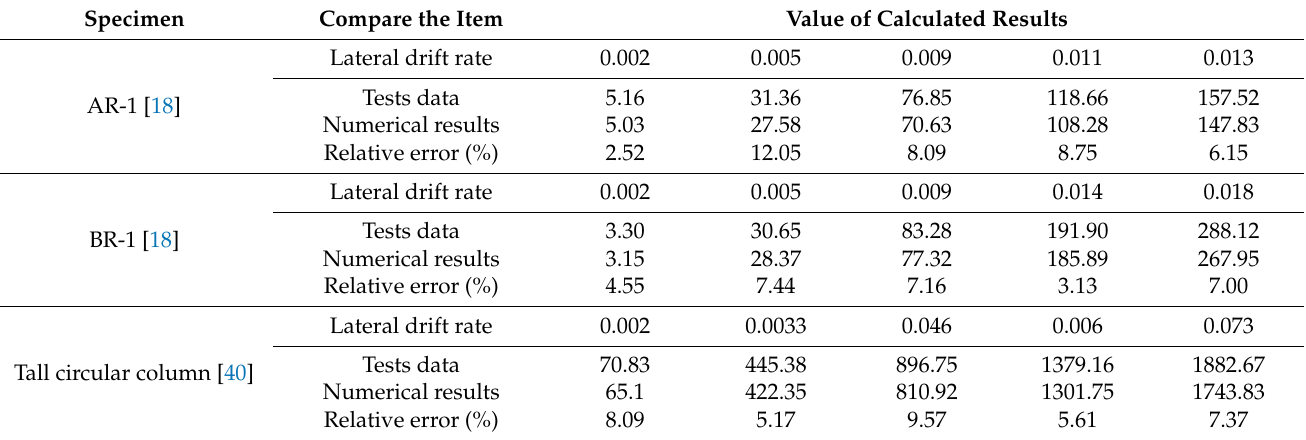
Table 1. Comparison of tests data and numerical results for energy dissipation of fiber reinforced polymer-confined reinforced concrete (FRP-C RC)